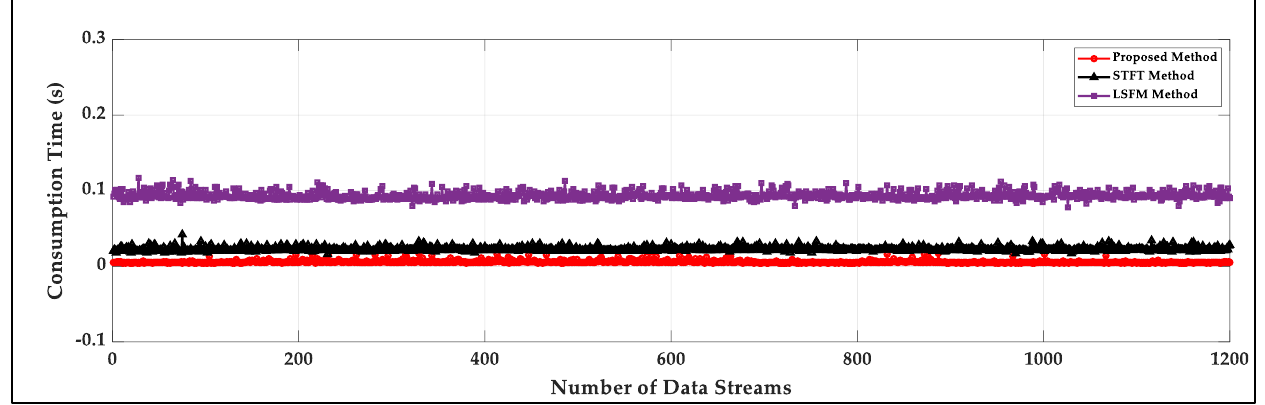
Figure 11. The consumption time of signal activity detection for the proposed method, the LSFM method and the STFT method.